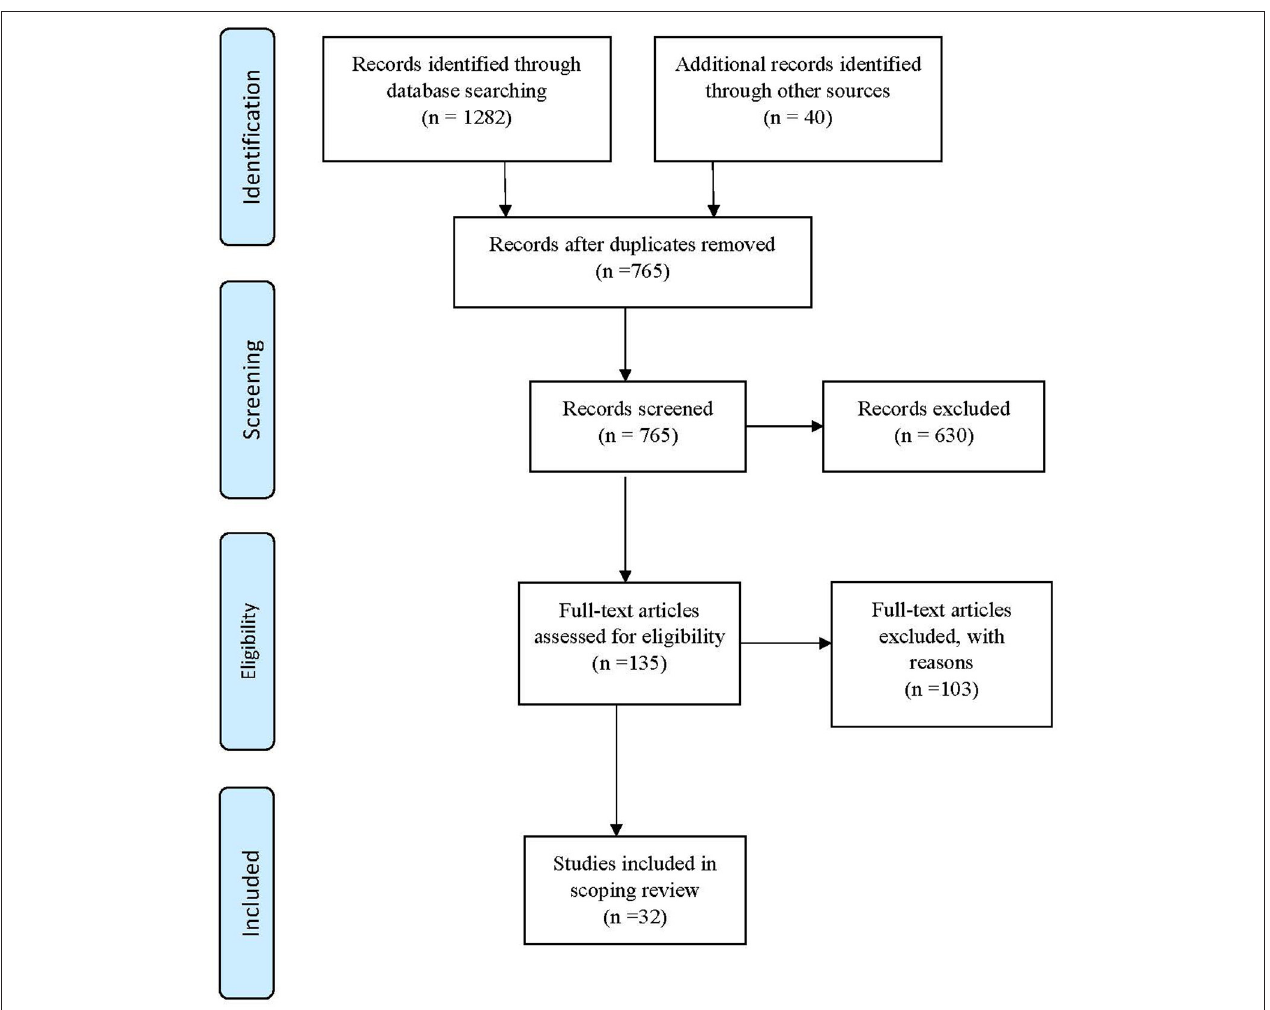
FIGURE 1 | PRISMA flow chart